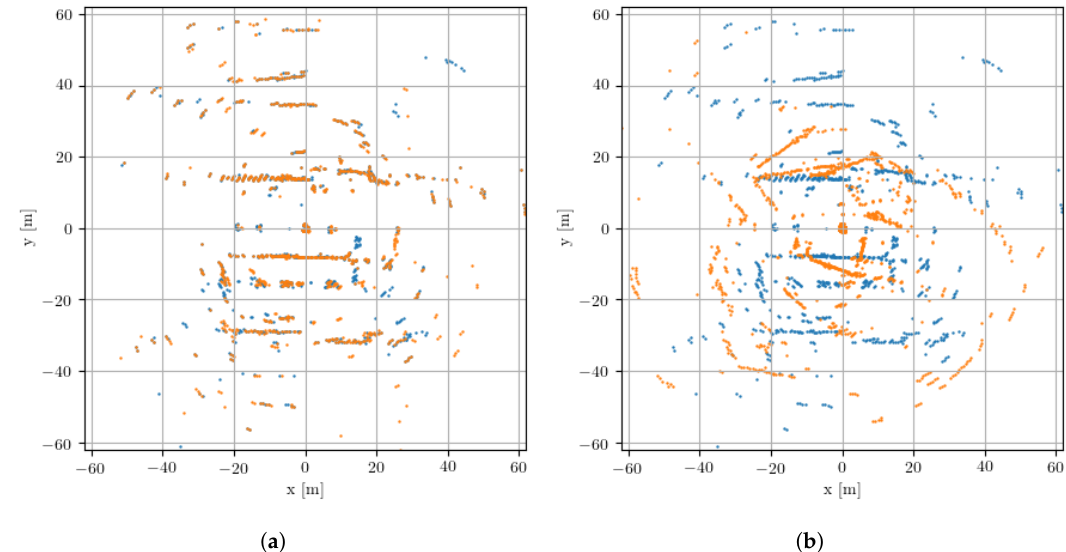
Figure 3. Example landmark sets after detection on radar scans as described in Section 3.2 where in Figure 3a | L 1 | = 1029 (orange) and | L 2 | = 1074 (blue). In ( a ), the orange landmark set is highly compatible with the blue landmark set. This is because the the scans underlying these sets are taken from very proximal locations. This pair of sets corresponds to the (“bright”) compatibility matrix illustrated in Figure 4b. In contrast, ( b ) shows the same landmark set (orange) alongside a highly incompatible landmark set from a farflung location (blue). This example corresponds to the (“dark”) compatibility matrix illustrated in Figure